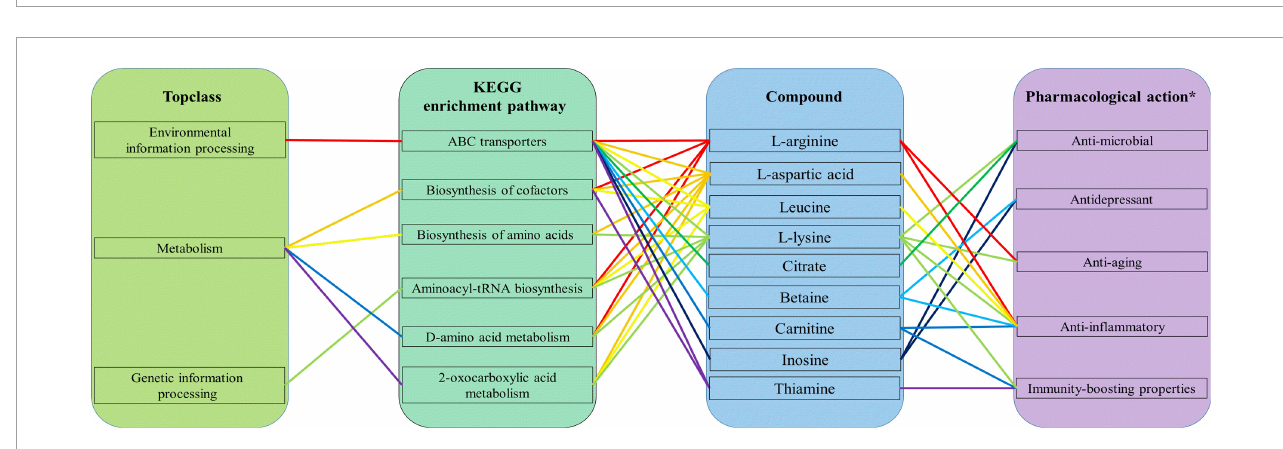
FIGURE9 The top-class of the KEGG enrichment pathway and pharmacological action of nine main compounds produced by Lactiplantibacillus plantarum during fermentation of Polygonati Rhizoma; *information on the pharmacological action is obtained from the literature